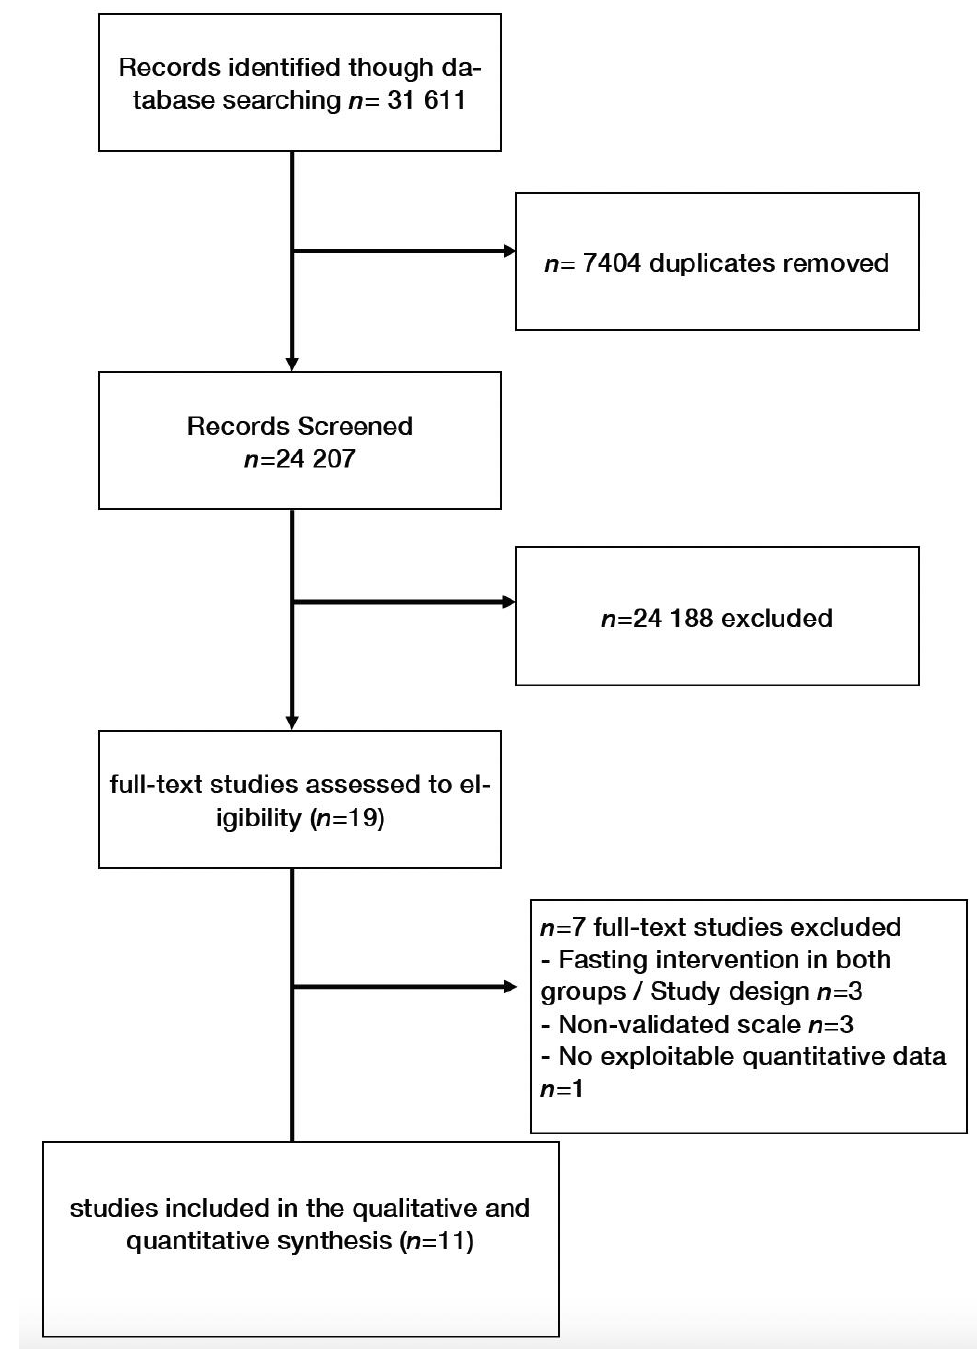
Figure 1. Flow chart.